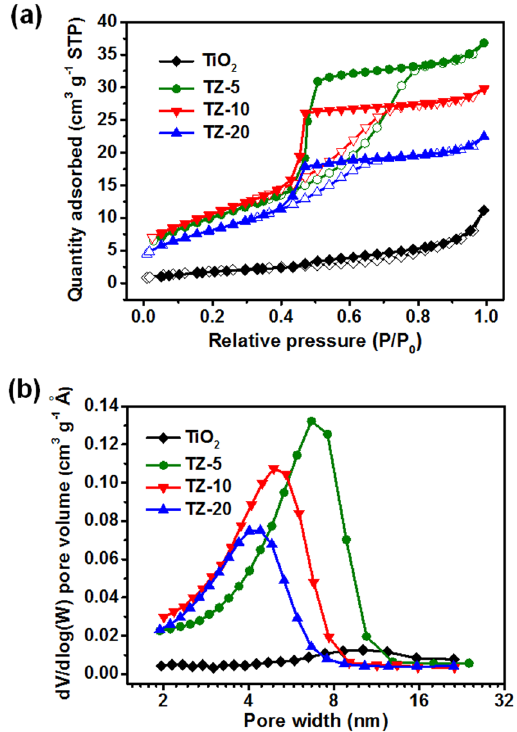
Figure 4. ( a ) N 2 adsorption-desorption isotherms of TiO 2 , TZ-5, TZ-10, and TZ-20 nanofibrous membranes. ( b ) Pore distribution analysis of the relevant membranes using the BJH method.